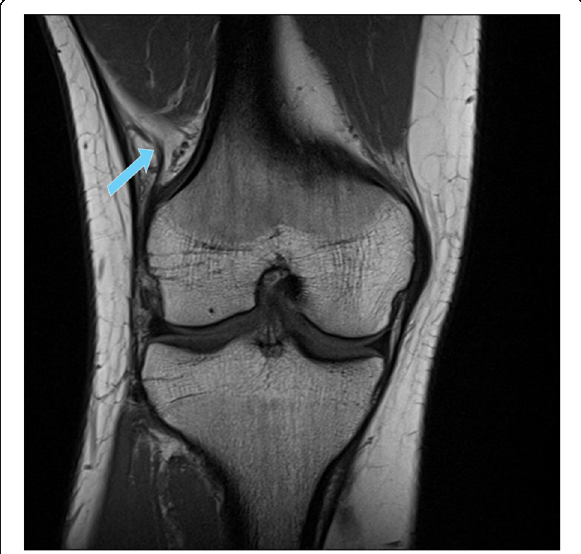
Fig. 2 Deep attachments of the iliotibial tract (ITT) to the distal femur (blue arrow) as seen in 60.6% of the examined cases (coronal T1-weighted